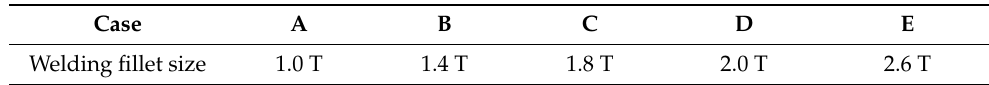
Table 6. Simulation